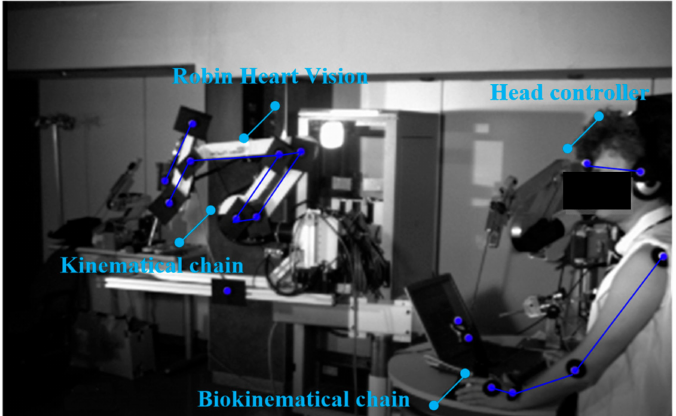
Figure 3. Robin Heart Vision surgical robot for soft tissue surgery and head controller and robot operator with reflective markers attached to the biokinematic